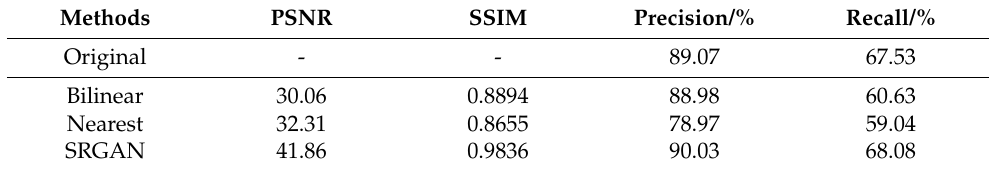
Table 2. PSNR results of image reconstruction and target recognition network detection